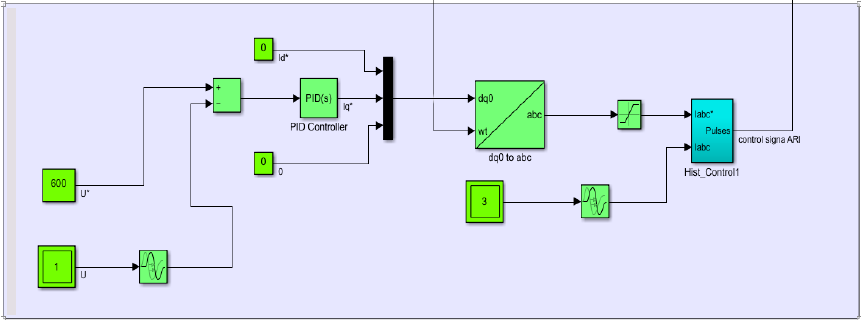
Figure 16. Simulation model of the AR control block.